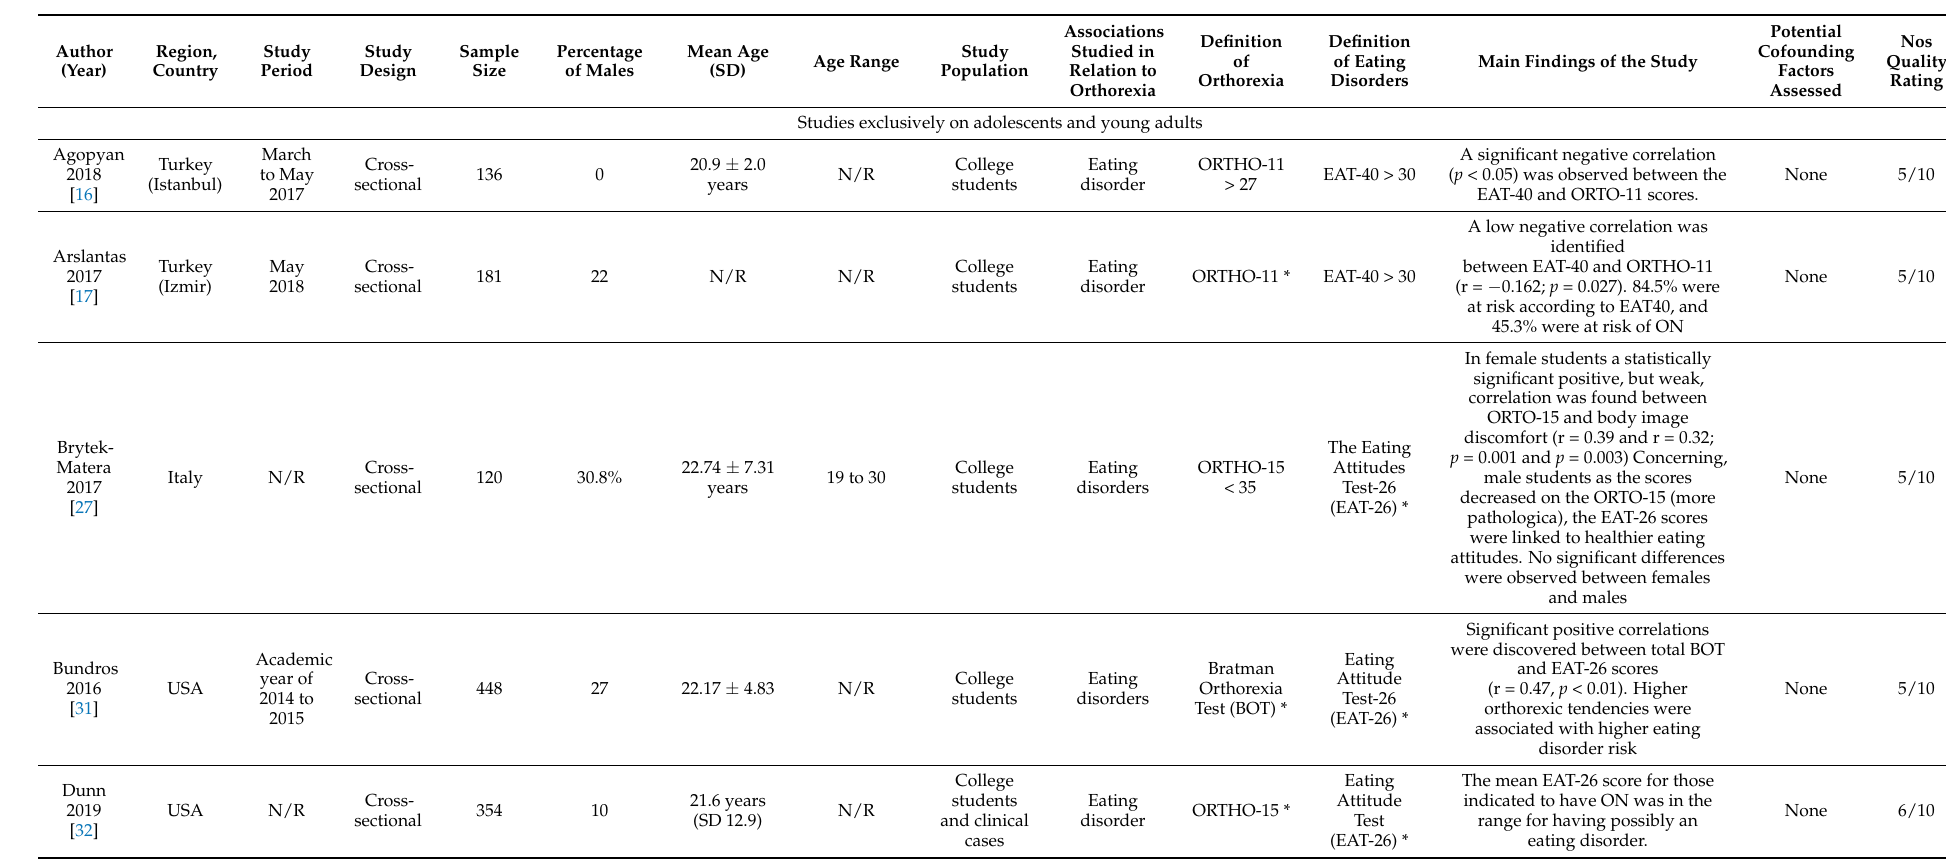
Table 1. Demographic characteristics of eligible studies. Studies performed exclusively on adolescents and young adults are presented in the upper panels, while studies with admixture with older individuals are presented in the middle panels. Studies concerning prognosis and features of eating disorders are presented in the lower